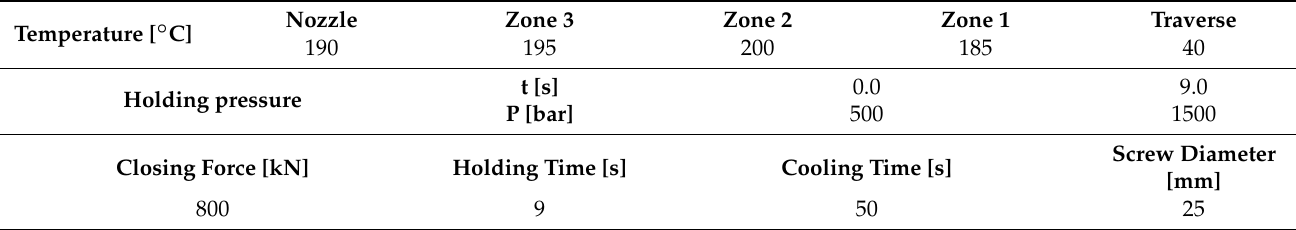
Table 1. Injection moulding parameters.